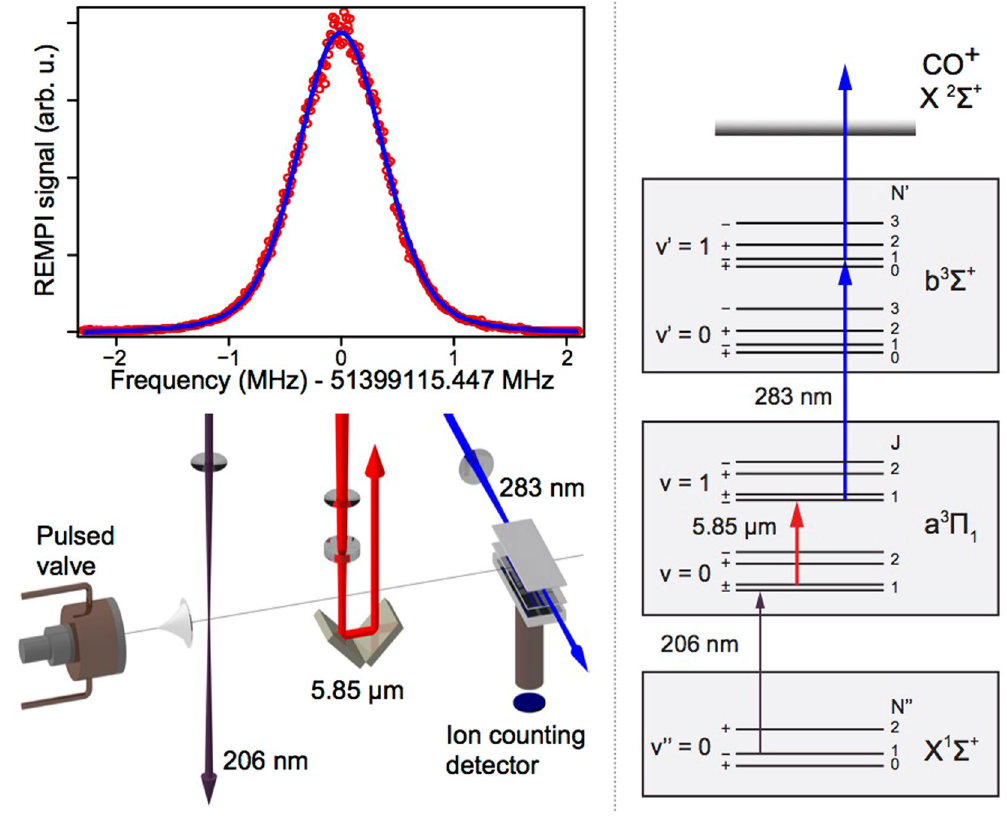
Figure 3. Top: a typical vibrational absorption spectrum on the ∏ a 3 metastable state of CO measured in about 1 25 minutes. The transition | = = −〉 ← | = = +〉 v J v J 1, 1, 0, 1, shows a width of 900 kHz. A Voigt fit of the data (blue line) yields an uncertainty of 3 kHz on the center frequency. Bottom: sketch of the molecular beam apparatus used for the measurement. The beam is generated by a pulsed valve operated at 10 Hz. CO molecules are skimmed, excited into the metastable state by a UV laser at 206 nm, interact with the mid IR laser, and are finally detected by resonance-enhanced multiphoton ionization. Ions are collected on a microchannel plates detector. Right: level diagram of the states involved in the triple resonance